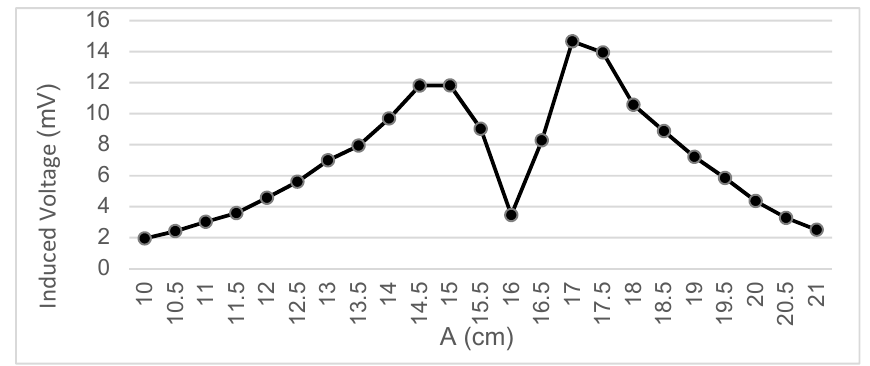
Figure 10. Data representation for B = 15 m, C = 2.35 cm; Test 4.5.